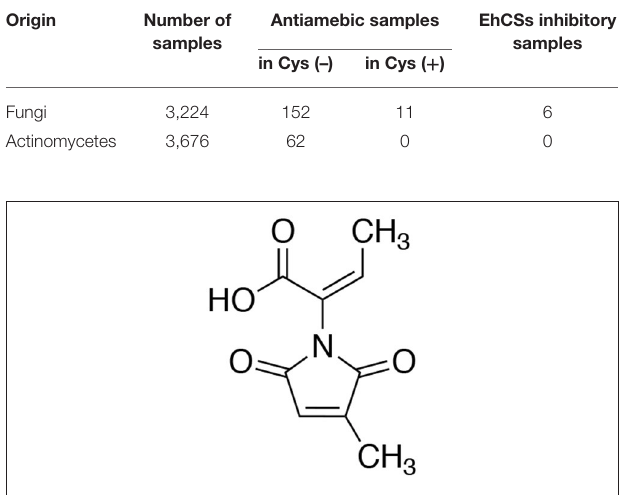
FIGURE 2 | Structure of